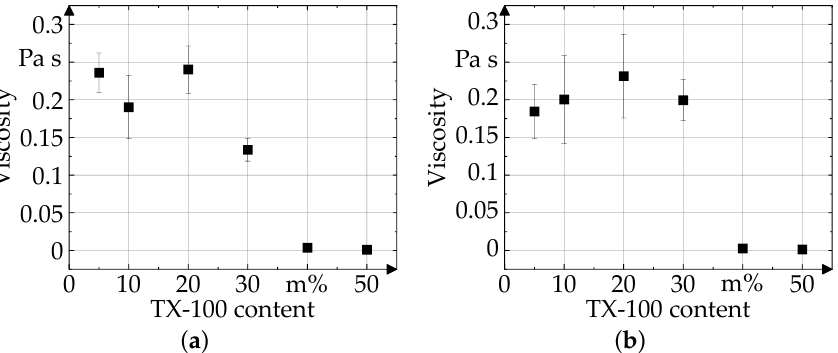
Figure 8. Viscosity as a function of TX-100 content for aqueous dispersions containing 10 m% graphite nanoparticles at varying pH values ( a ) pH = 9 (see Table A3) and ( b ) pH = 10.75–11 (see Table A12).